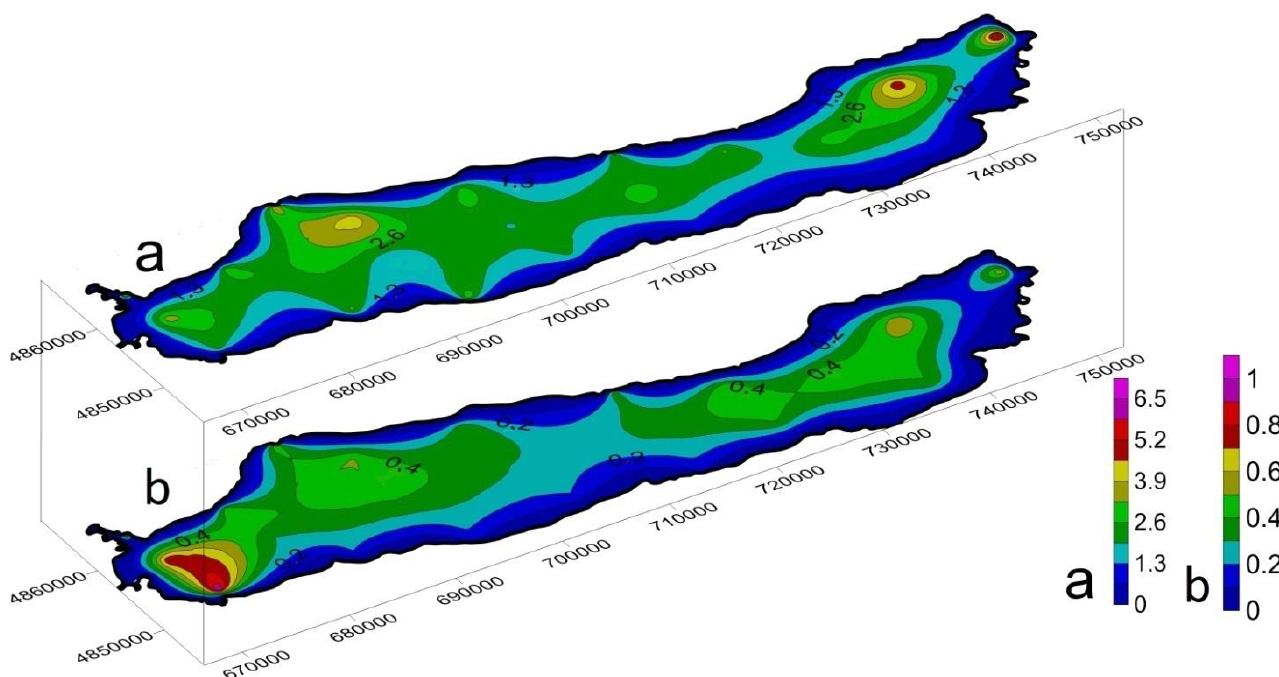
Figure 6. Spatial distribution of cadmium in water and bottom sediment of the Kapshagay Reservoir. ( a ) Water — µg/L; ( b ) bottom sediment — mg/kg. (authors Ismukhanova L.T., Madibekov A.S.)